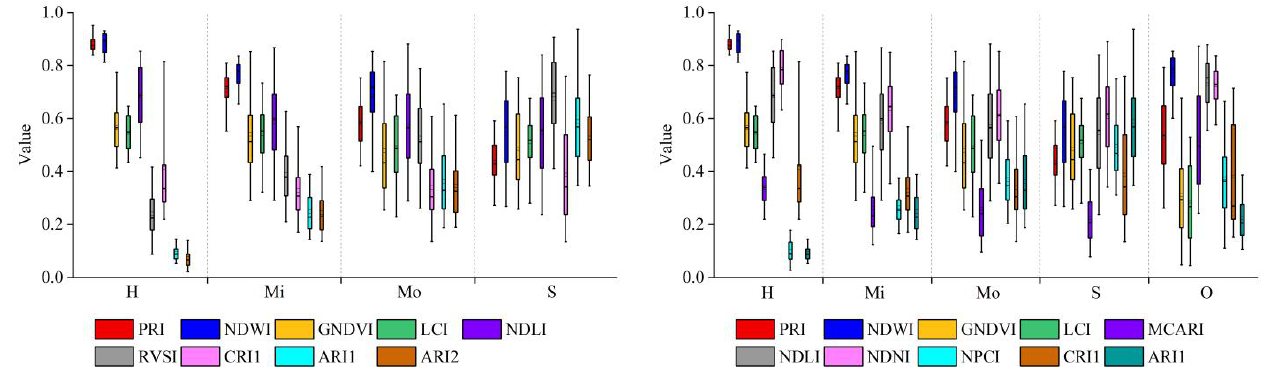
Figure 7. Variations of selected features in different groups of leaves for scenario-A ( left) and scenario-B ( right ) for the training dataset.